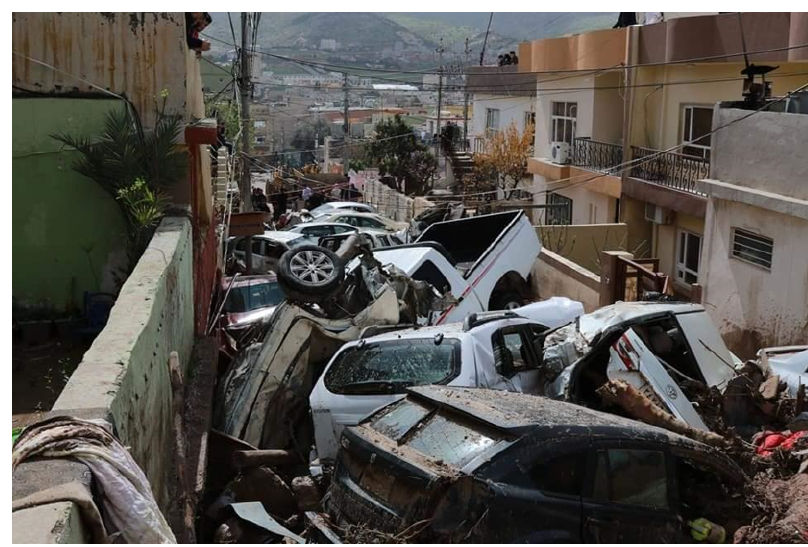
Figure 6. Consequences of the flood on Duhok city [68] .